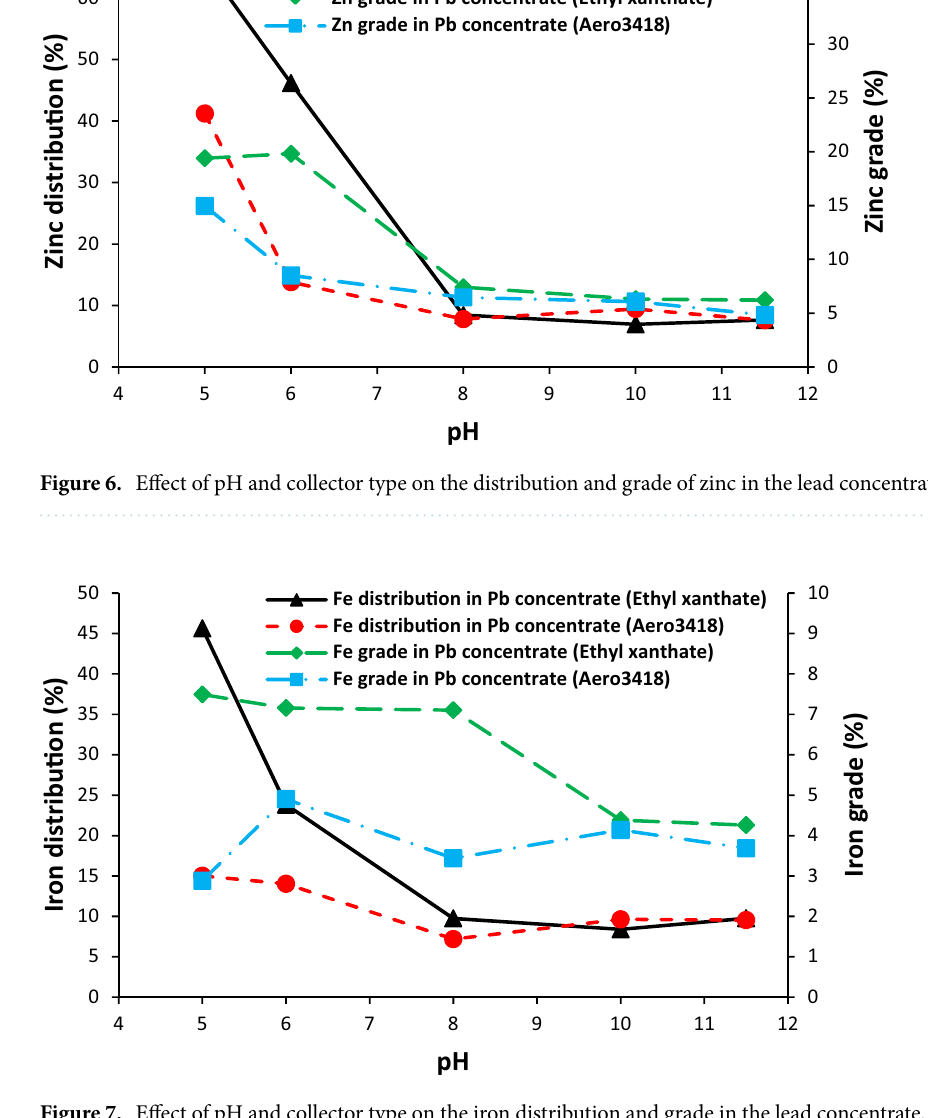
Figure 7. Effect of pH and collector type on the iron distribution and grade in the lead